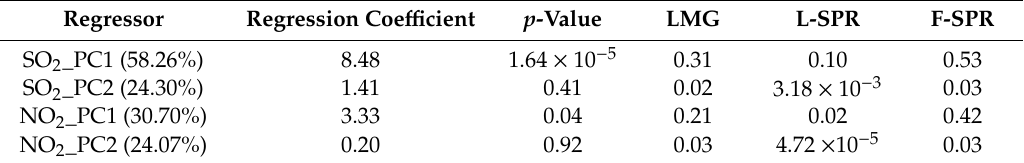
Figure 6. Comparison of the observed PM 2.5 variations in northern China and the predicted one. Note that the annual cycles have been removed from each variable prior to modeling analysis. Table 2. Estimated regression coefficients and LMG measures for each regressor. L ‐ SPR (F ‐ SPR) denotes the semi ‐ partial coefficient of determination gains when the regressor was added as the least (first) regressor into the model. Numbers in brackets are percent variances explained by each principal component.